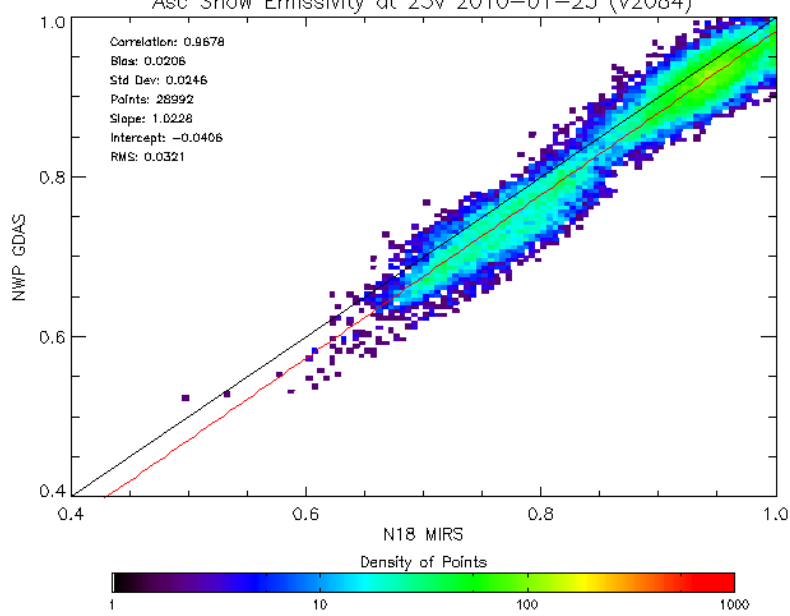
Figure 8. Difference between MiRS-retrieved 23 GHz emissivity over land surfaces from NOAA-18 and analytically computed emissivity from the collocated GDAS analysis on 23 January 2010 ( top ), along with scatter plots and statistics for points over snow-free land ( middle ) and snow-covered land ( bottom ).These results indicate that the MiRS emissivities over land are reasonably accurate with a standard deviation between 2% and 3%, including errors due to collocation, time matching and due to the reference emissivity used.